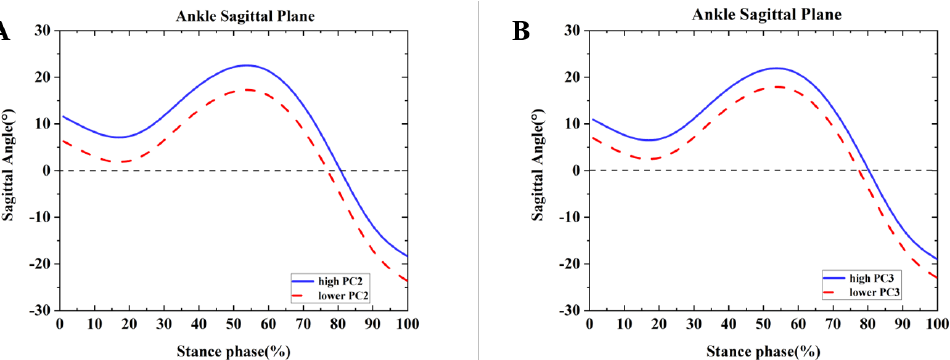
Figure 2. Principal components are retained for the ankle. ( A ) The waveform differences between competitive runners and recreational runners of reconstruction principal using the high and lower PC2-scores in the ankle sagittal plane. ( B ) The waveform differences between competitive runners and recreational runners of reconstruction principal using the high and lower PC3-scores in the ankle sagittal plane.